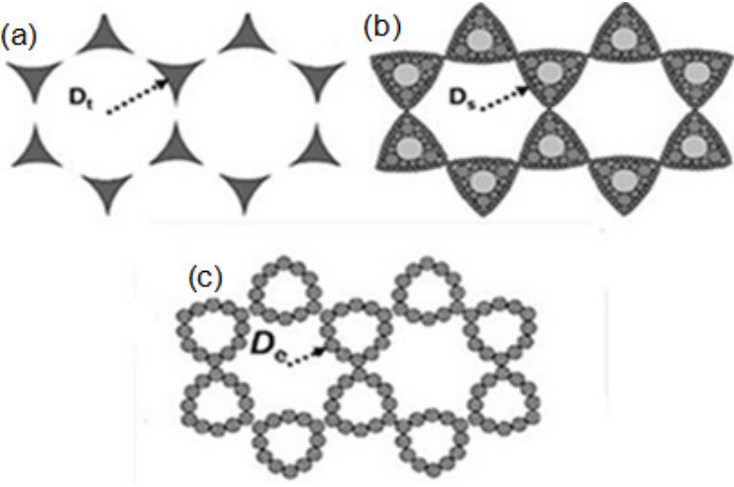
Figure 11. Schematic diagrams of silver nano-lattice structures ( a ) thermal evaporation; ( b ) RF magnetron sputtering; and ( c ) e-gun deposition.